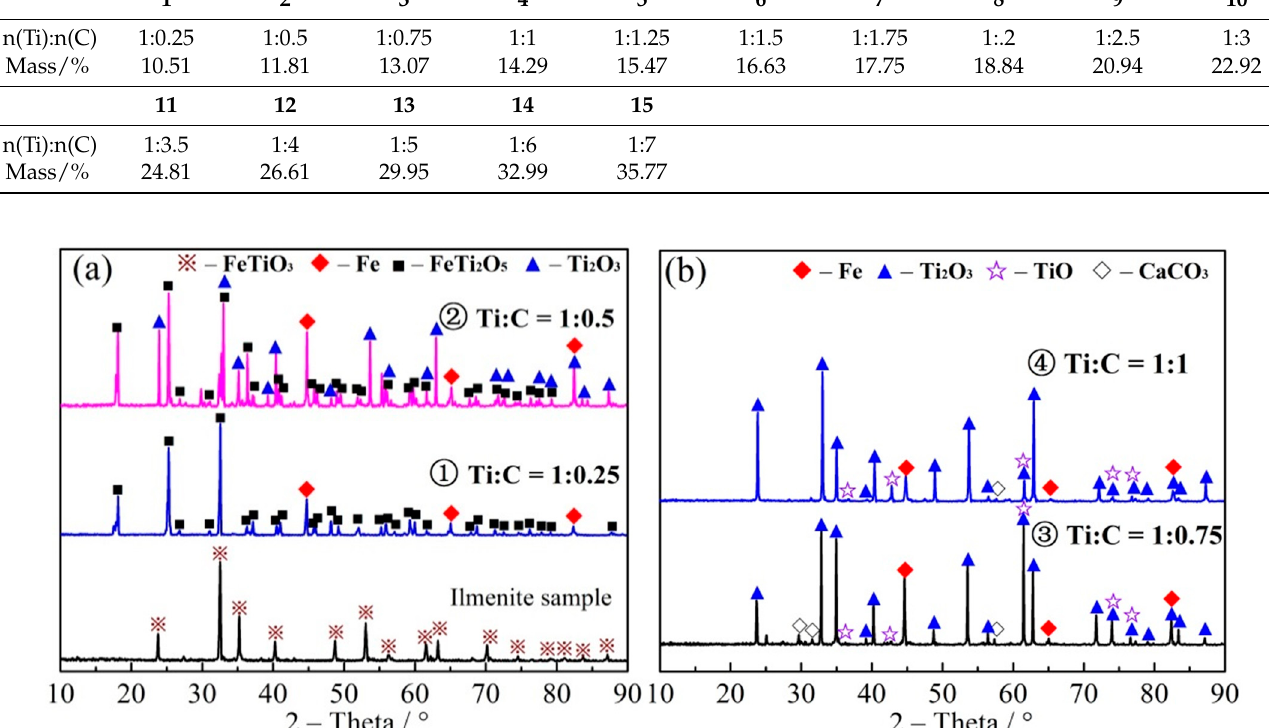
Table 2. Titanium and carbon ratio.